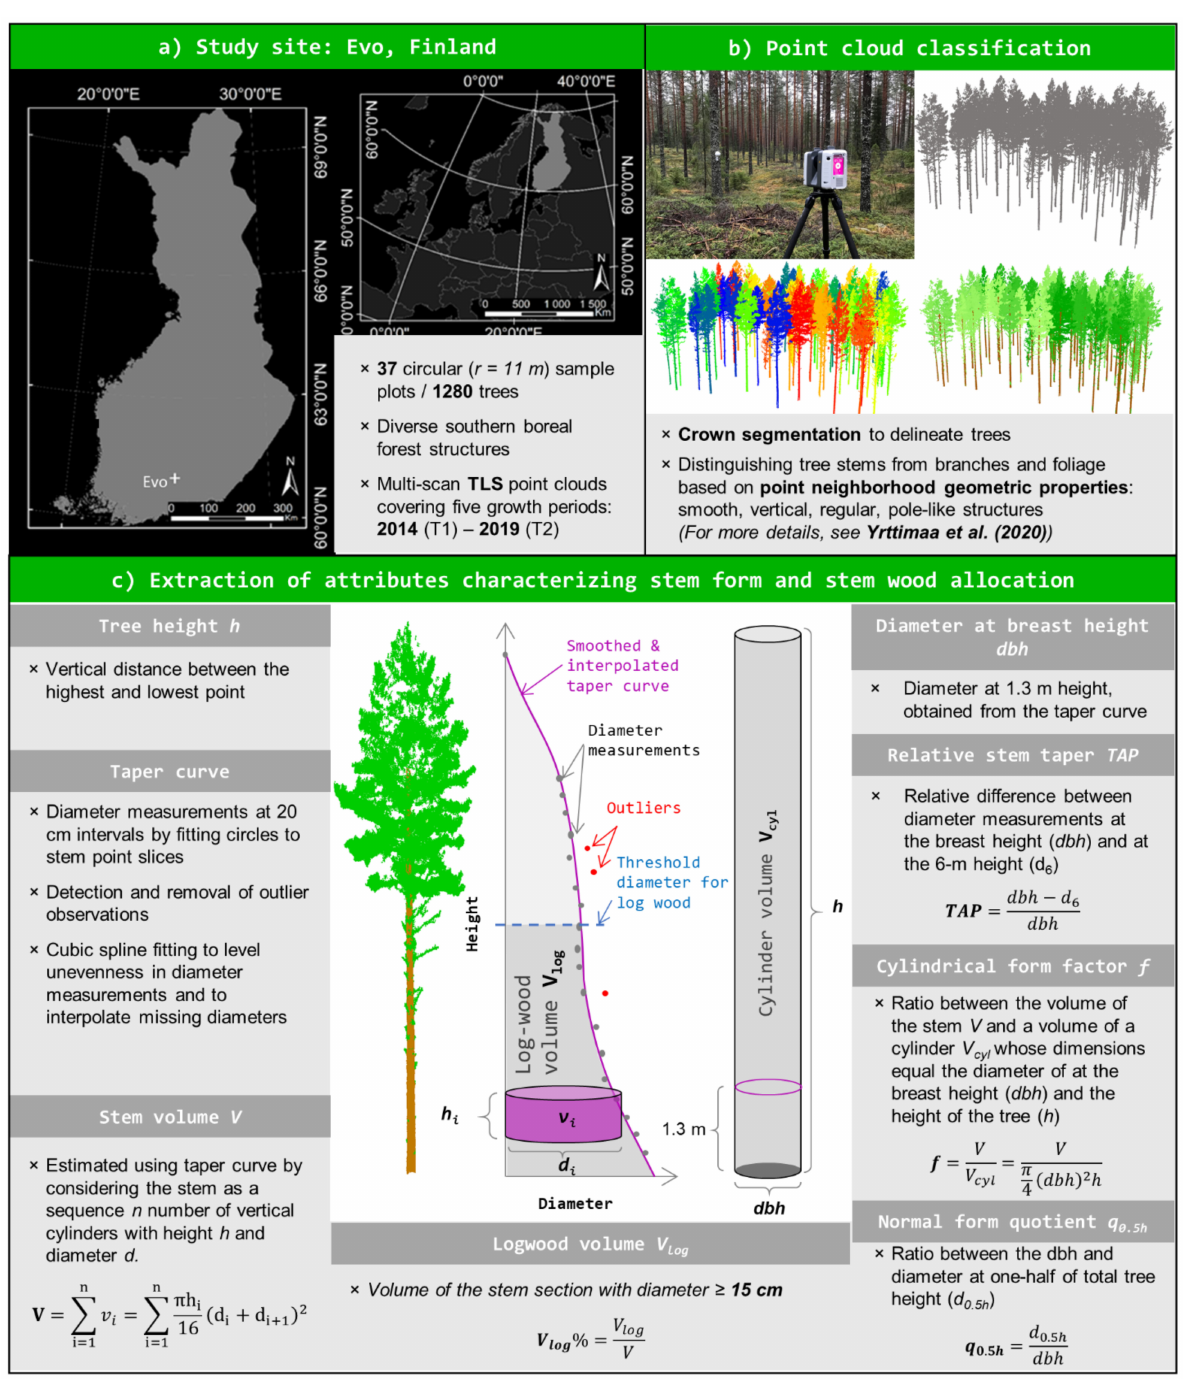
Figure 1. Description of the study site location as well as the point cloud processing methods used to derive attributes characterizing stem form and stem wood